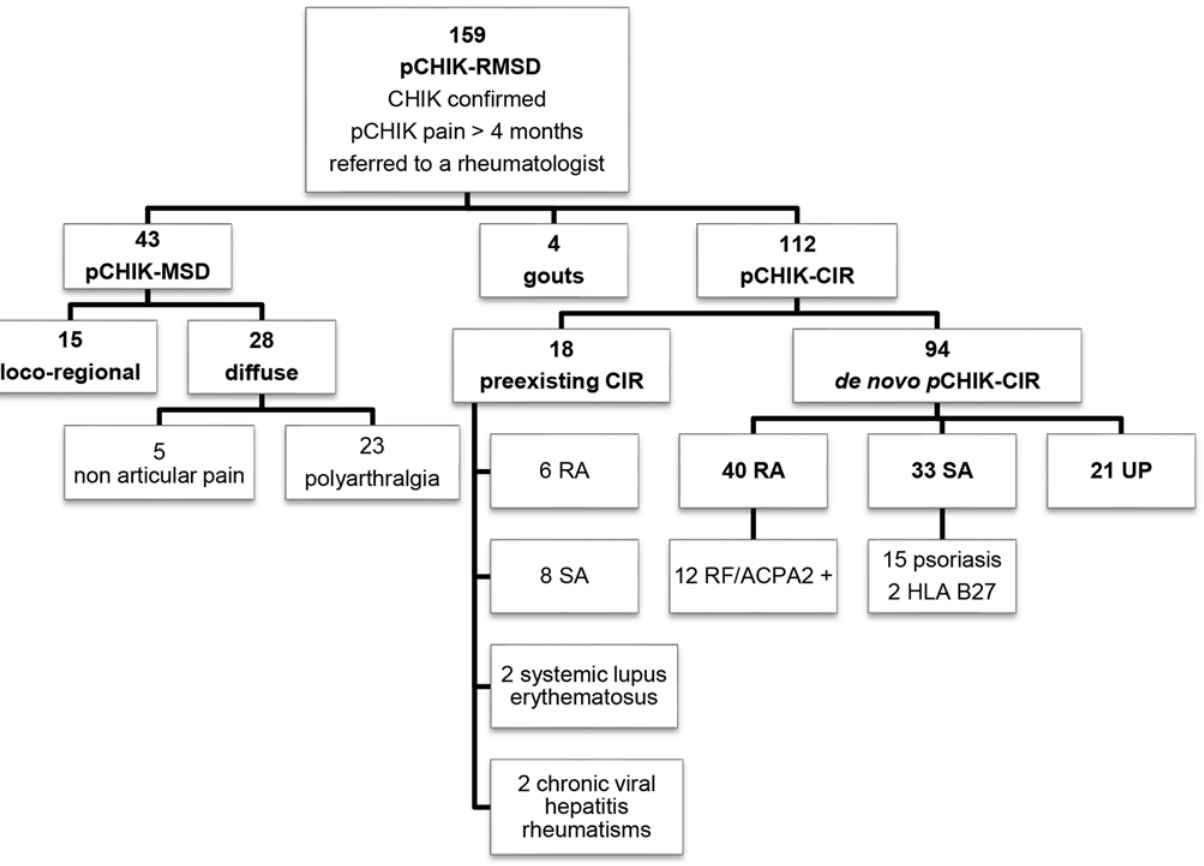
Fig 1. Nosologic flow-chart of patients referred to a rheumatologist for post-chikungunya (pCHIK) persistent rheumatic musculoskeletal pain, Saint-Denis, Reunion Island, 2006 – 2012.